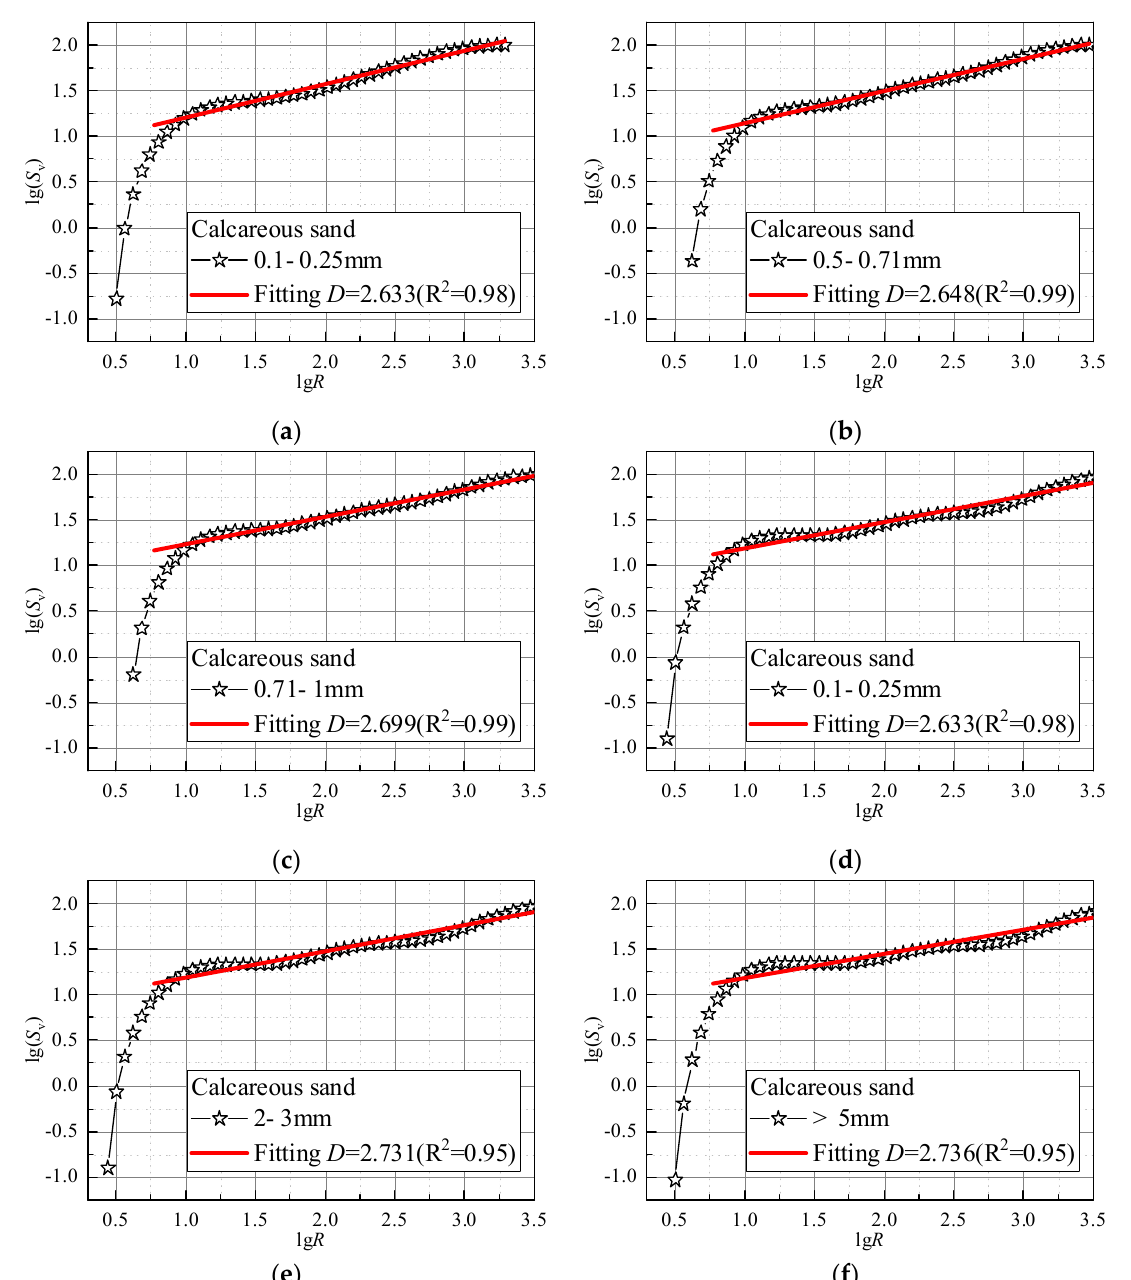
Figure 8. Determination of fractal dimension of calcareous sand with different grain sizes: ( a ) 0.1–0.25 mm; ( b ) 0.5–0.71 mm; ( c ) 0.71–1 mm; ( d ) 0.1–0.25 mm; ( e ) 2–3 mm; ( f ) >5 mm.